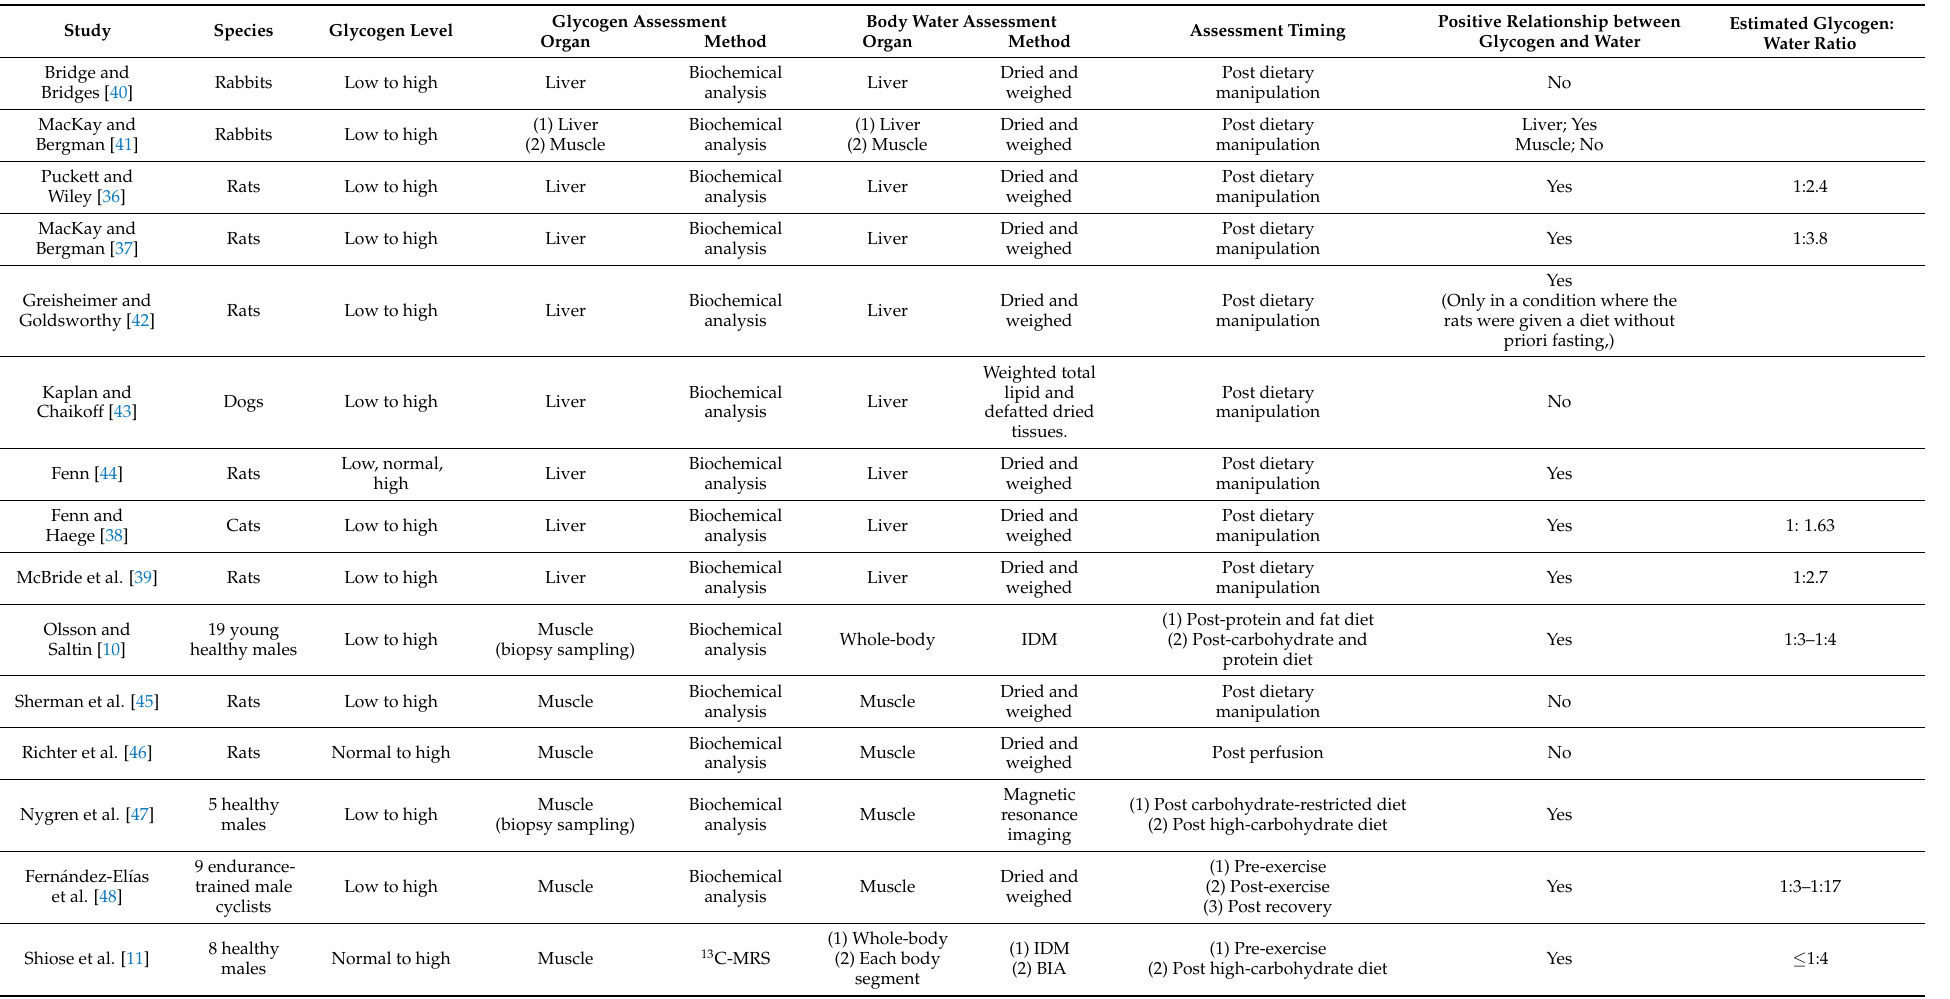
Table 1. Studies involving muscle or liver glycogen and body water